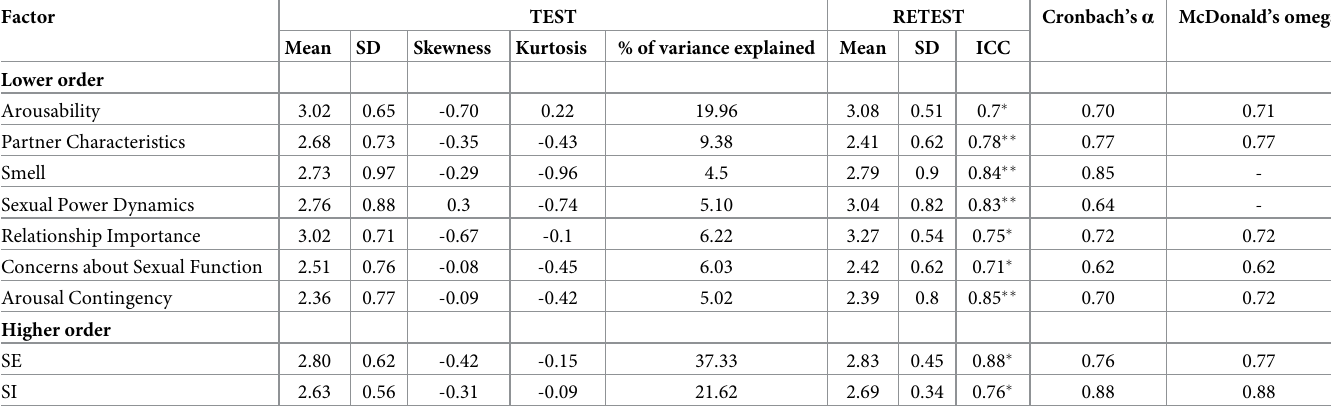
Table 5. General statistics for the lower- and higher-order factors of the SESII-W-PL.